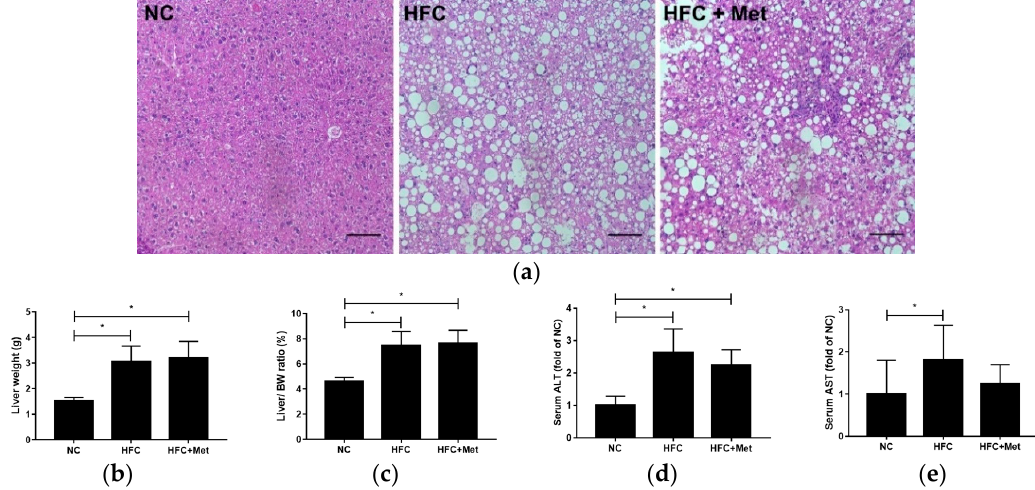
Figure 2. Effects of the high-fat and high-cholesterol diet and metformin supplementation on ( a ) hepatic histology, ( b ) liver weight, ( c ) liver to body weight ratio, ( d ) serum alanine aminotransferase (ALT) and ( e ) serum aspartate aminotransferase (AST) in the male mice: Hepatic sections were stained with hematoxylin and eosin. Data are expressed as means ± SD (Figure 2a: n = 6; 2b–e: n = 9–15 per group). * p < 0.05 as determined by one-way ANOVA followed by LSD post hoc test. NC, normal diet; HFC, high-fat and high-cholesterol diet; HFC + Met, HFC with metformin supplementation. Scale bar: 200 μ m.